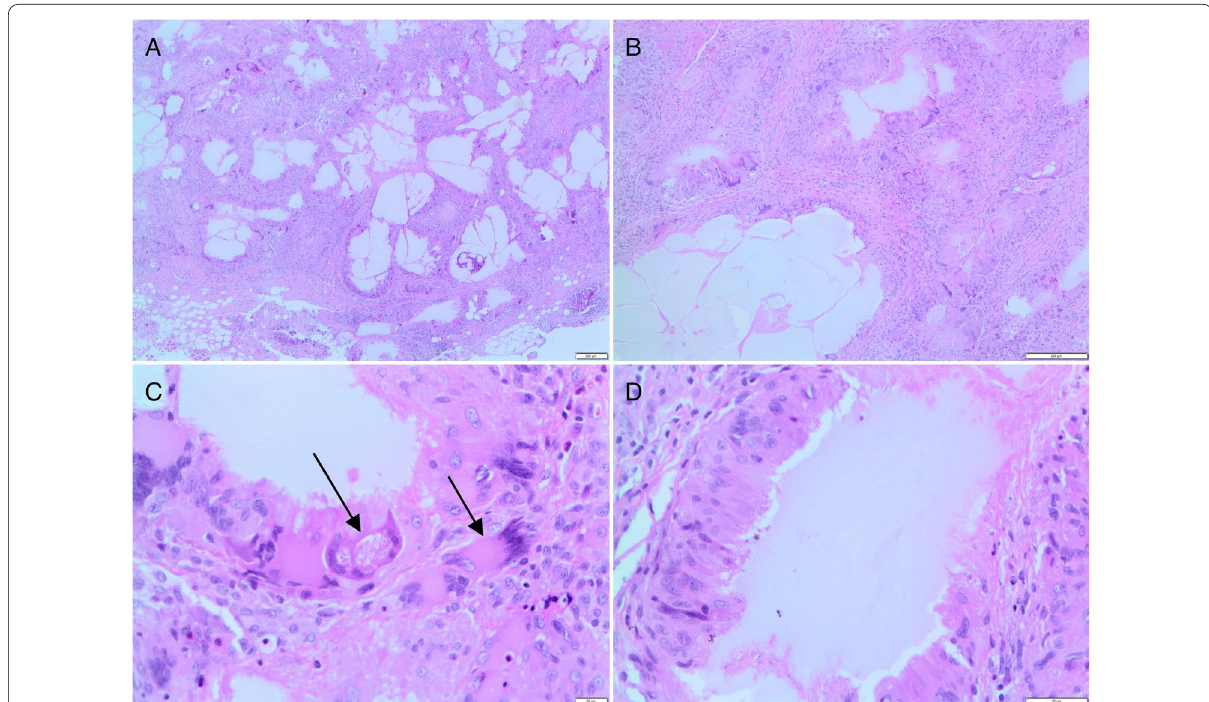
Fig. 1 Submucosal fibroadipose tissue almost entirely effaced by multiple empty spaces and large pools of pale staining eosinophilic material ( A ) eliciting a prominent foreign-body giant cell granulomatous response ( B ). Non-necrotizing granulomatous inflammation with numerous multinucleated foreign-body giant cells ( C , arrowed) surround the pale pink stained material ( D ) (H&E stain; original magnification B ). 400 ( C , D ×